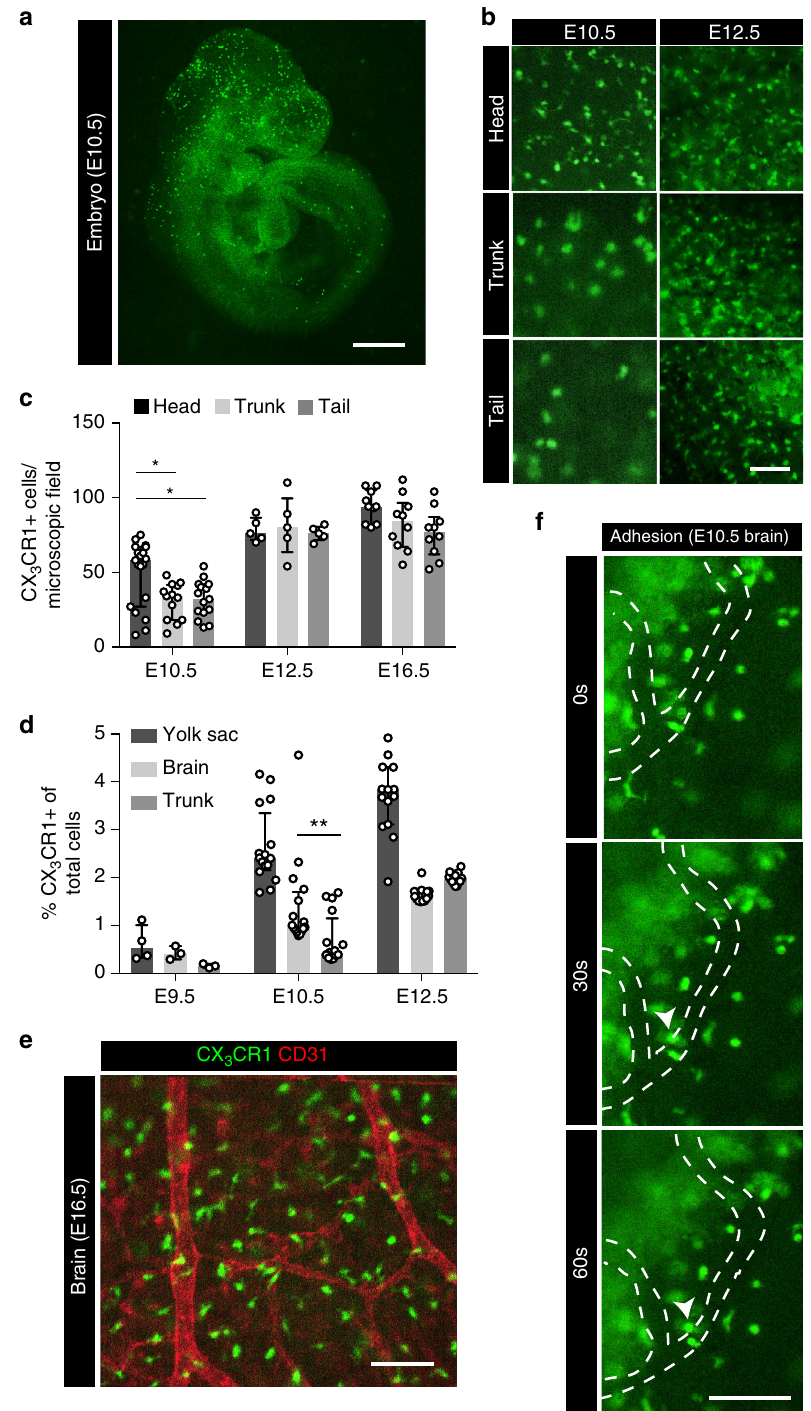
Fig. 2 Pre-macrophages in fi ltrate embryonic tissues. a Isolated E10.5 Cx 3 cr1 GFP/ + embryo. b , c Visualization ( b ) and quanti fi cation ( c ) of CX 3 CR1+ macrophages in different embryonic regions at indicated time points; * p < 0.05 (one-way ANOVA with Tukey ’ s multiple comparisons test: head vs. trunk p = 0.0107, head vs. tail p = 0.0121, trunk vs. tail p = 0.9860); graph shows median ± IQR. d Quanti fi cation by fl ow cytometry of CX embryonic YS, brain and trunk at indicated time points; (**) p = 0.0017 (two-tailed Mann – Whitney test); median ± IQR. e CX 3 CR1 GFP+ cells (green) in the embryonic brain at E16.5 additionally stained for the endothelial marker CD31 (red). f Image series extracted from live E10.5 video sequences (Supplementary Movie 6) show a cell attaching to the endothelium in the embryonic head region; direction of fl ow from top to bottom. Scale bars are 1 mm ( a ), 100 µ m ( b , e , f